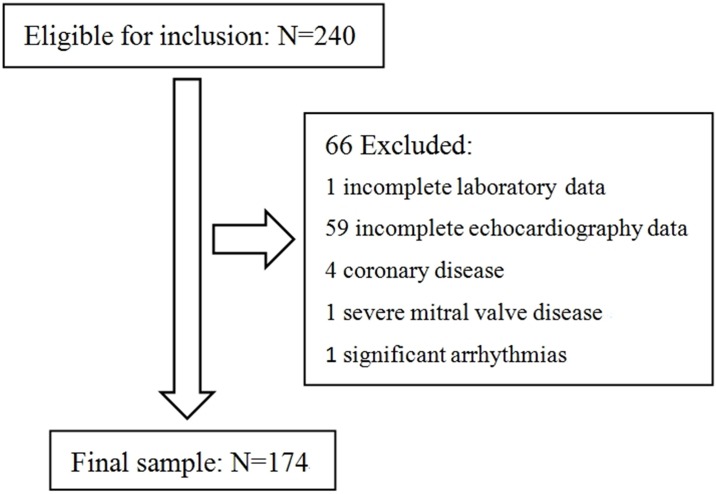
Study flow, including patient enrollment, and exclusions based on patients’ characteristics.